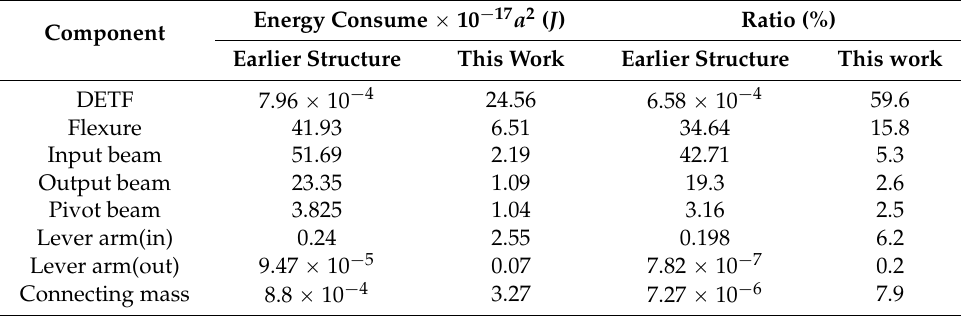
Table 2. Energy consumed in each component of the SMRA.